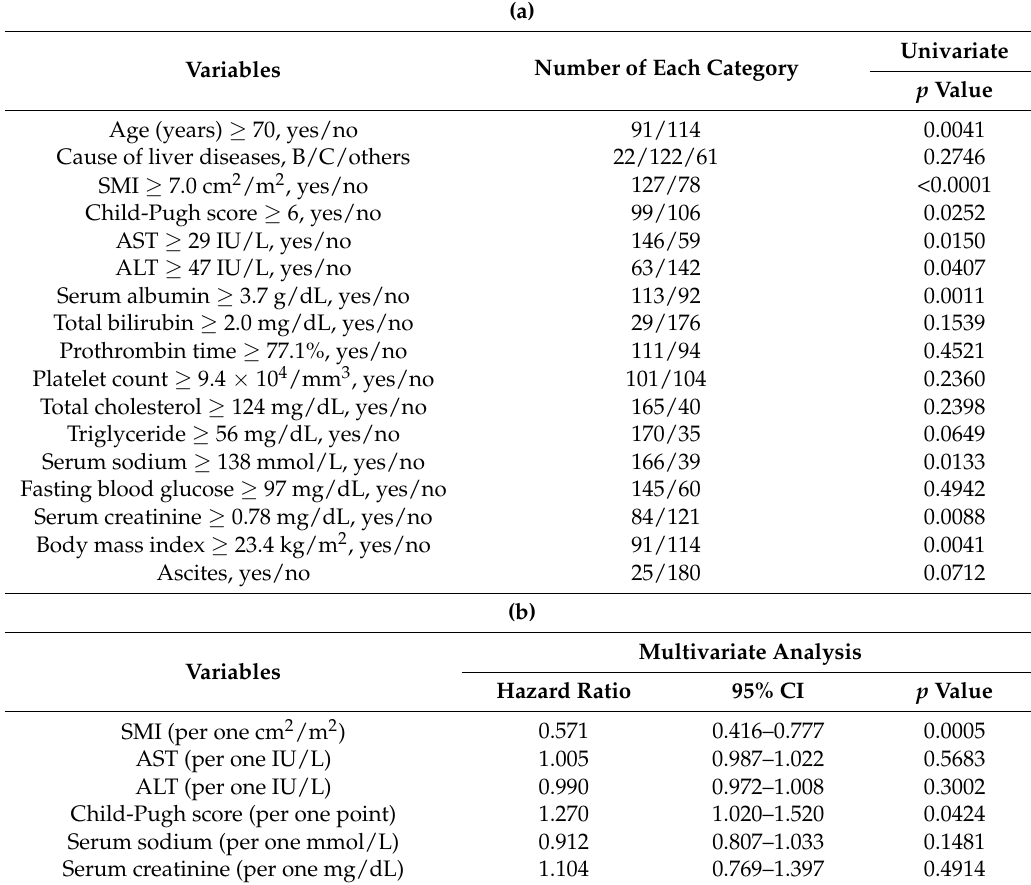
Table 2. ( a ) Univariate analyses of factors linked to overall survival for males ( n = 205). ( b ) Multivariate analyses of factors linked to overall survival for